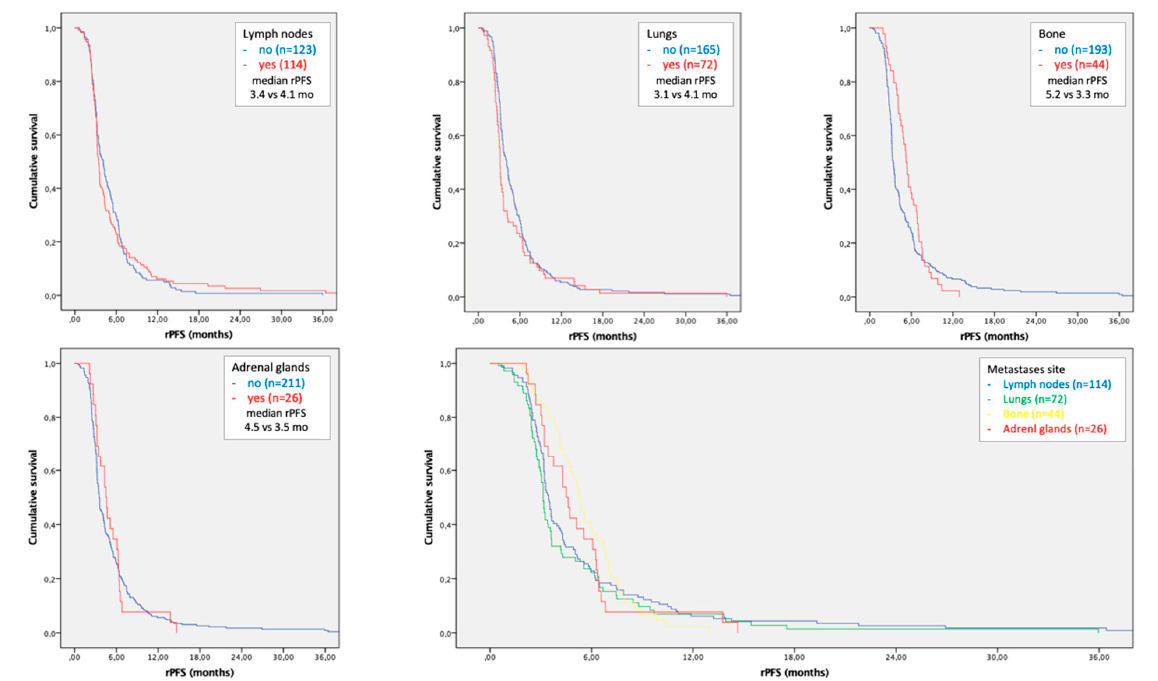
Figure 5. Kaplan–Meier curves of radiological progression-free survival for each site of metastases. The last figure compares the survival curves of lymph node, lung, bone and adrenal gland site of metastases.